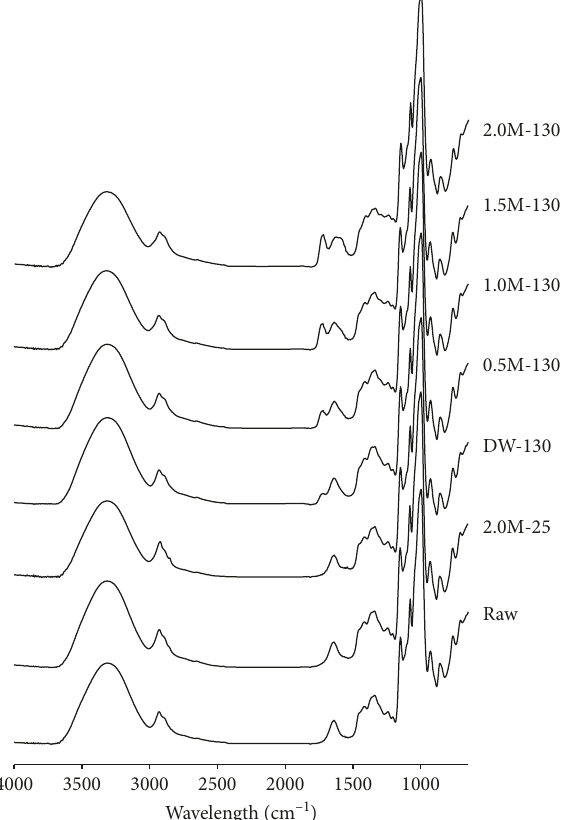
Figure 2: FT-IR spectra of raw and malic acid-treated sweet potato